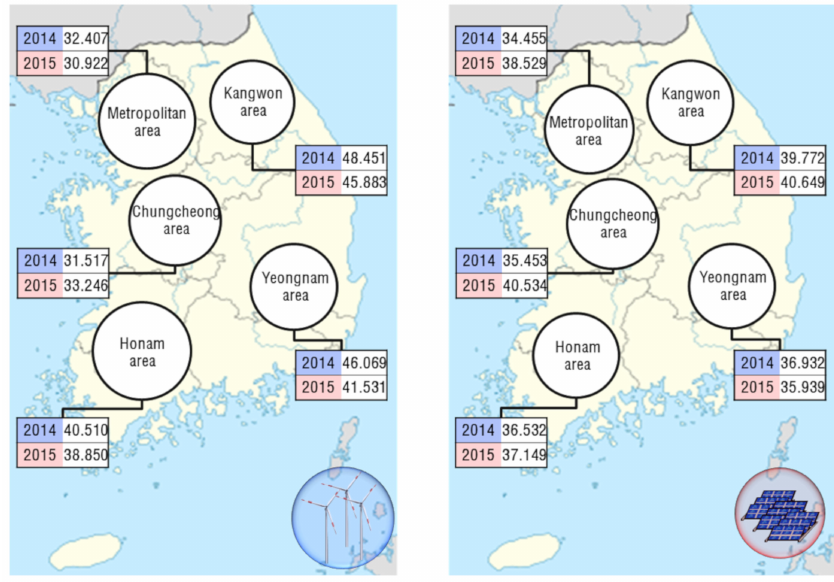
Figure A7. Maximum capacity factor for renewable energy in di ff erent areas